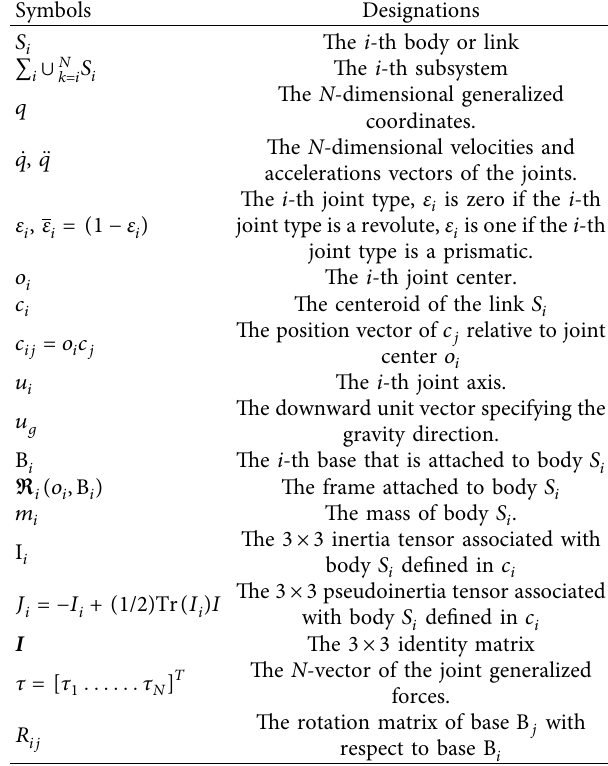
Table 1: Notations for the new